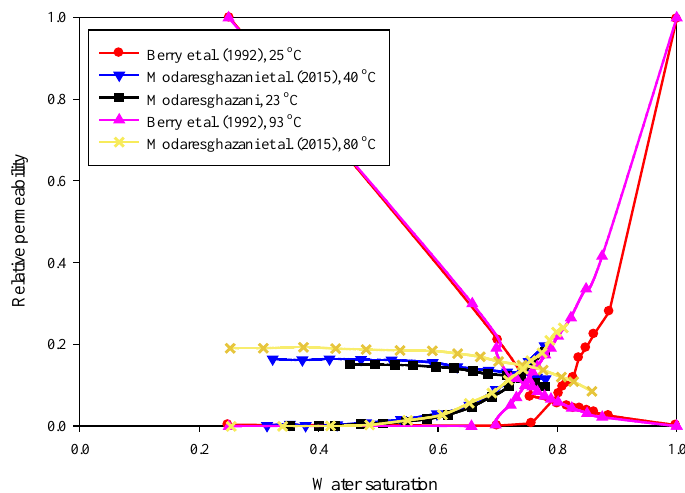
Figure 5. E ff ect of viscosity ratio on two-phase gas / liquid-relative permeability with varying Figure 5. Effect of viscosity ratio on two-phase gas/liquid-relative permeability with varying temperature temperature [14,16].